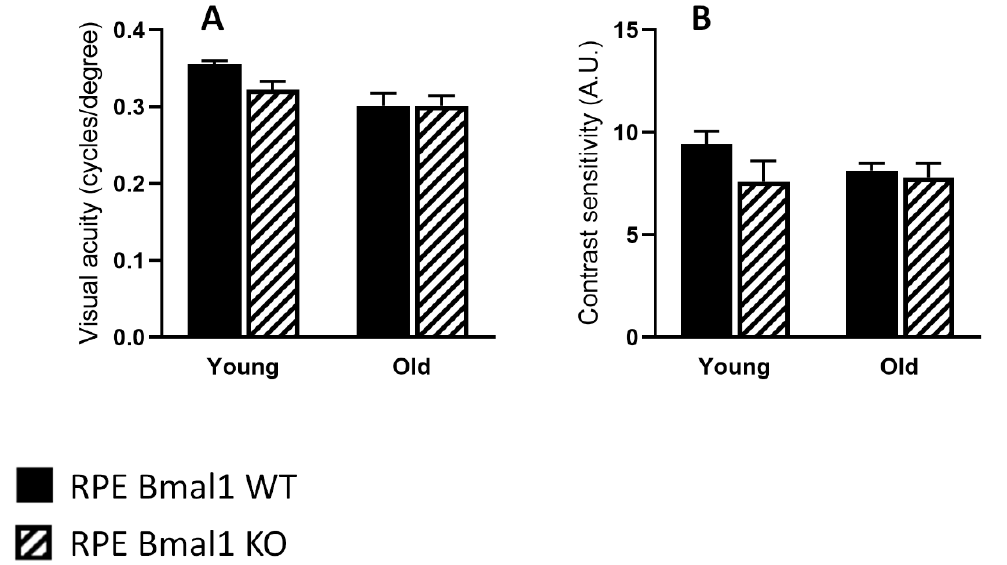
Figure 8. Psychophysical measurements of visual function are not affected by the absence of Bmal1 in RPE cells. Visual function was assessed with an optomotor response protocol. No differences were observed in visual acuity ( A , p > 0.1, two-way ANOVA) in RPE Bmal1 KO mice when compared to similarly aged RPE Bmal1 WT mice. Contrast sensitivity was also not affected in RPE Bmal1 KO when compared to RPE Bmal1 WT at all the ages tested ( B ; p > 0.1, two-way ANOVA, n = 4 – 6/group). Data are expressed as mean ± SEM.